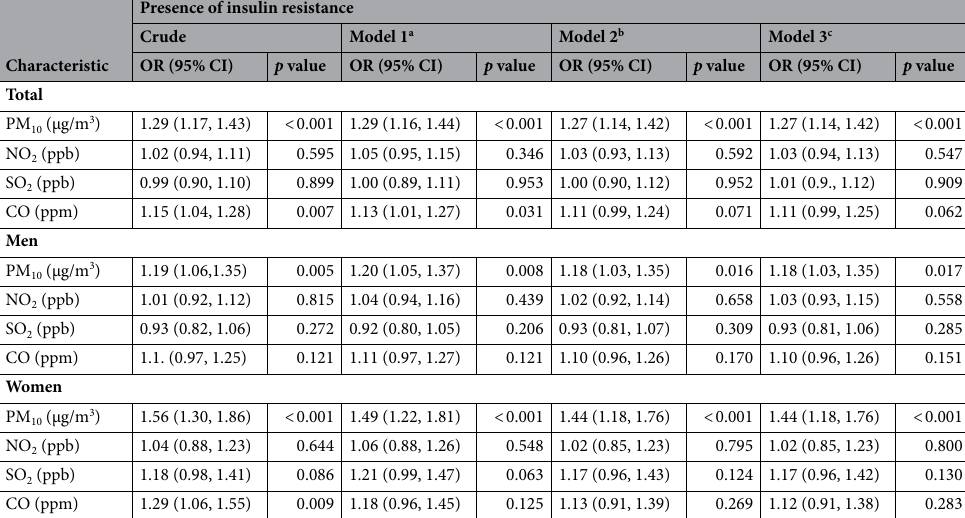
Table 4. Regression results for the association between exposure to ambient air pollution and the presence of insulin resistance. HOMA-IR homeostasis model assessment of insulin resistance index, PM 10 particulate matter with aerodynamic diameter ≤ 10 μm, NO 2 nitrogen dioxide, SO 2 sulfur dioxide, CO carbon monoxide, OR odds ratio, CI confidence interval. The ORs and 95% CIs of air pollutants were scaled to the interquartile range (IQR) for each air pollutant: 11 μg/m 3 for PM 10 , 14 ppb for NO 2 , 2 ppb for SO 2 , and 0.2 ppm for CO. a Model 1 was adjusted for age, BMI, smoking status (never, former, or current smoking), alcohol consumption (never, former, or current consumption), regular physical activity (yes or no), hypertension and dyslipidemia. b Model 2 included the variables in Model 1 plus VAT and SAT areas as covariates. c Model 3 included the variables in Model 1 plus VAT area as a